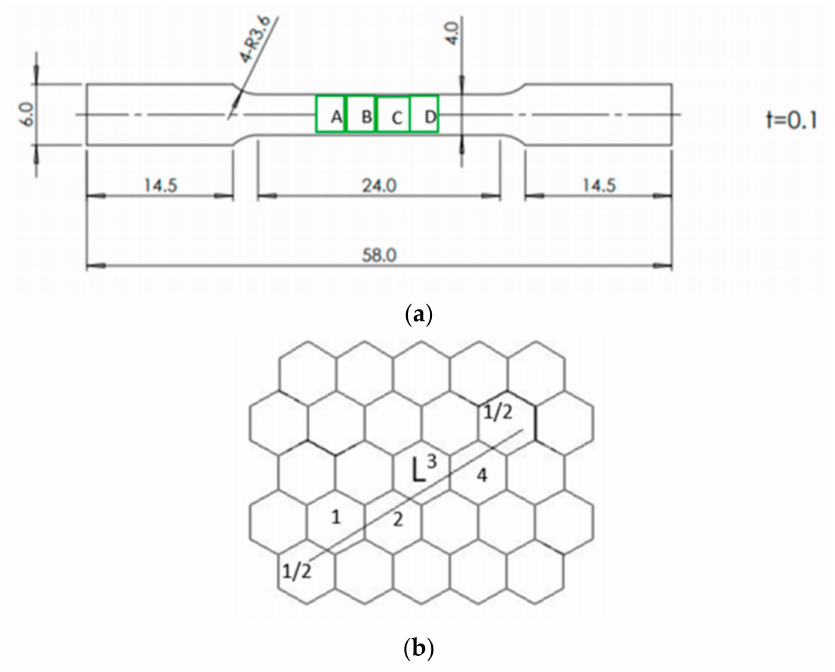
Figure 2. ( a ). Technical drawing specimen of tensile test. ( b ). The crystal structure photo micrograph